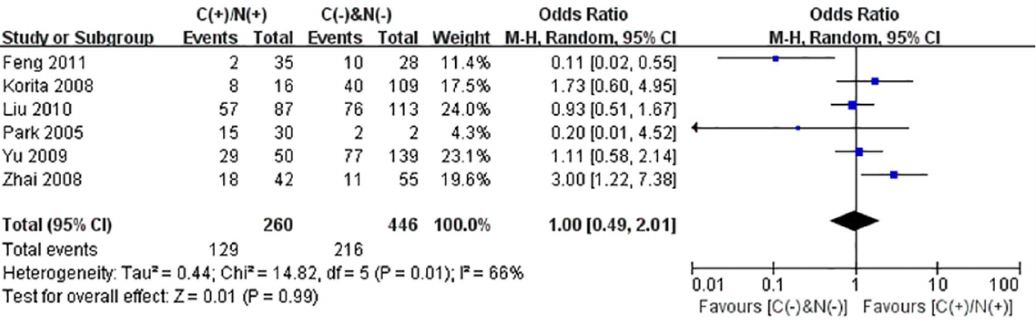
Figure 9. Forest plot of odds ratio for the association of b -catenin expression in cytoplasm and/or nucleus with tumor size.